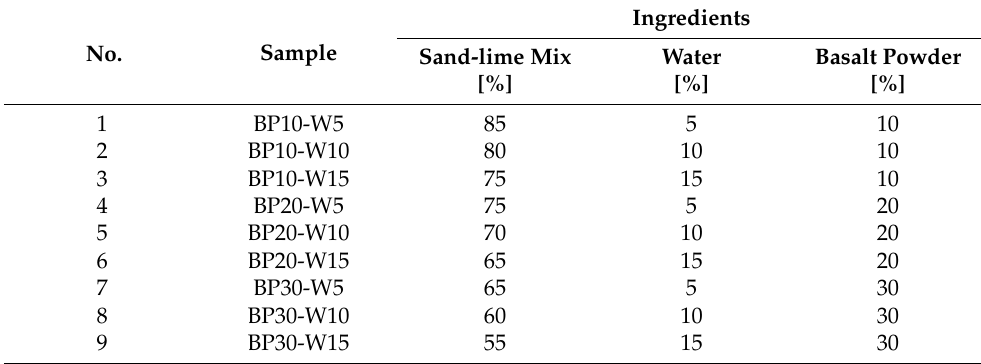
Figure 3. Experiment plan of mixtures with constraints—vertices and centroids generated for the tested range. Table 3. Composition of individual samples.